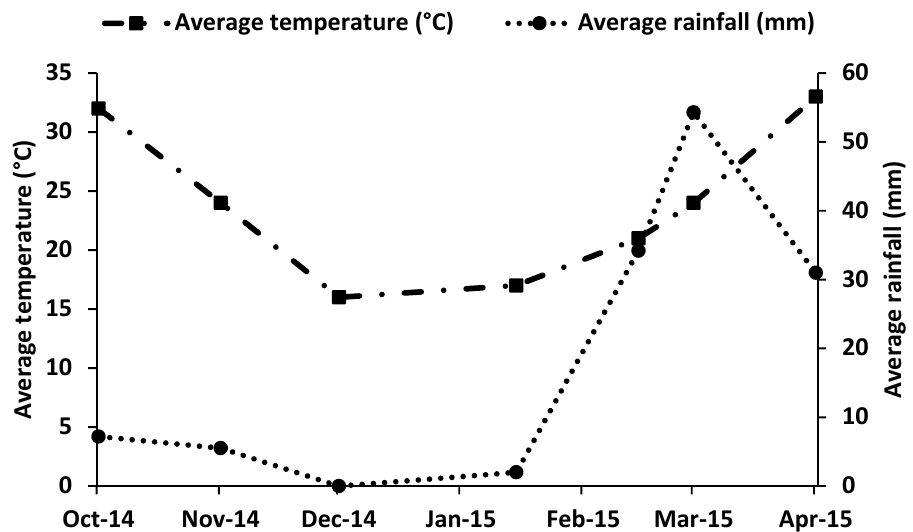
Figure 1. Average temperature (°C) and rainfall (mm) during the cropping season from October 2014 to April 2015.